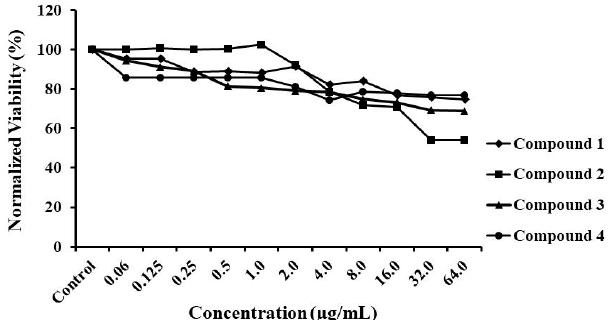
Figure 3. Thiazolylhydrazones derivatives to HepG2. The viability of HepG2 cells was measured after treatment with serially diluted concentrations (0.06–64.0 µ g/mL) of thiazolylhydrazones derivates. Cell viability was measured spectrophotometrically by detecting degradation of WST-1 dye into formazan by viable cells, which produces an intense color.